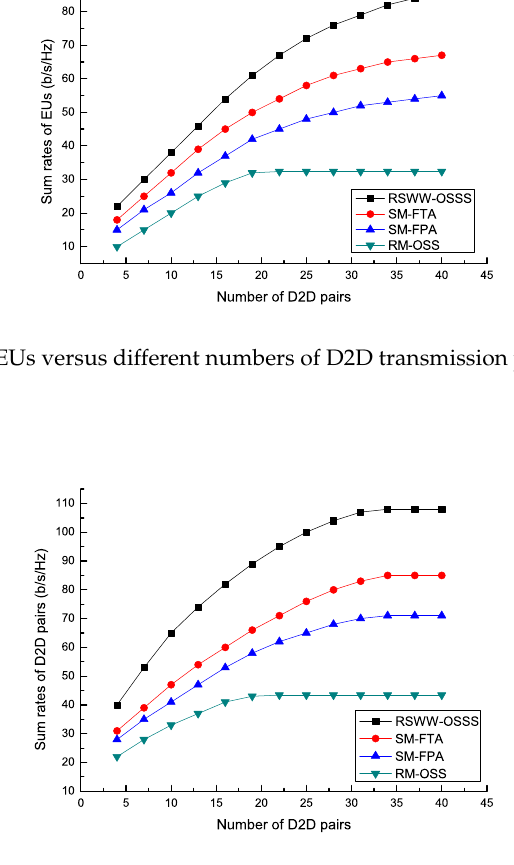
Figure 6. Sum-rate of D2D pairs versus different numbers of D2D transmission pairs when the number of EUs is